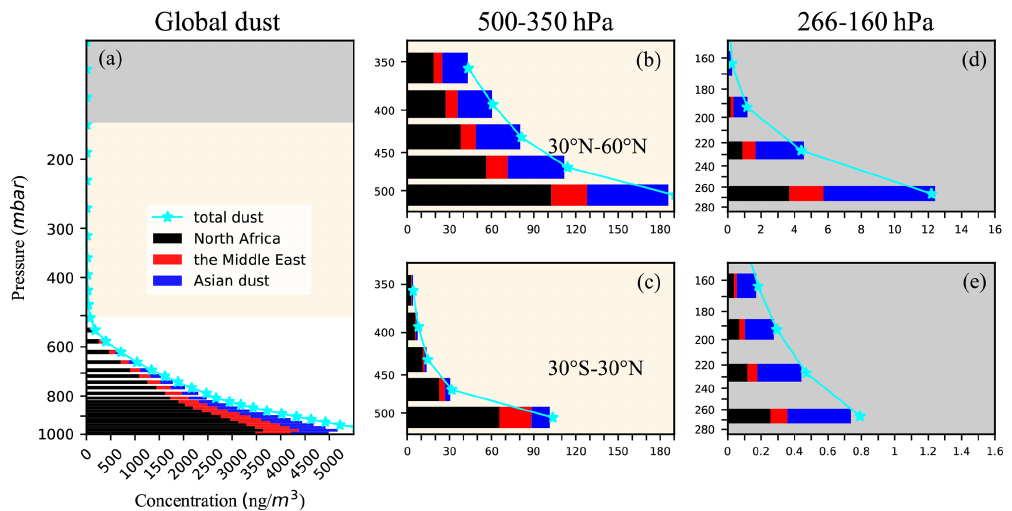
Figure 8. (a) Simulated vertical profiles of average dust concentration for 2014 to 2018 from each desert emission zone. Green bars denote North African dust, red bars denote Middle Eastern dust, and blue bars denote Asian dust. Panels (b–d) are the same as panel (a) but averaged for Northern Hemisphere (NH) mid-latitudes (30–60 ◦ N) and the tropics (30 ◦ S–30 ◦ N) from 500 to 350hPa. Panels (d–e) are the same as panels (b–c) but for pressure levels from 266 to 160hPa.